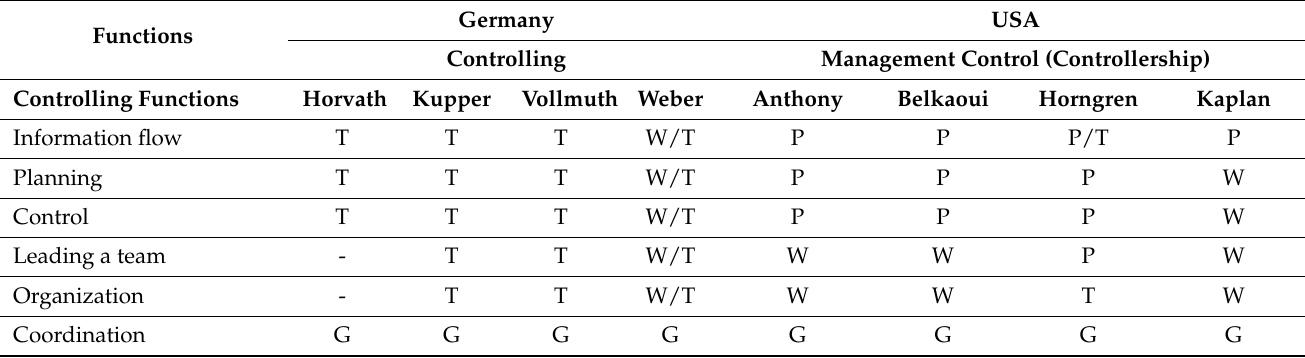
Table 1. Controlling functions according to the German and American